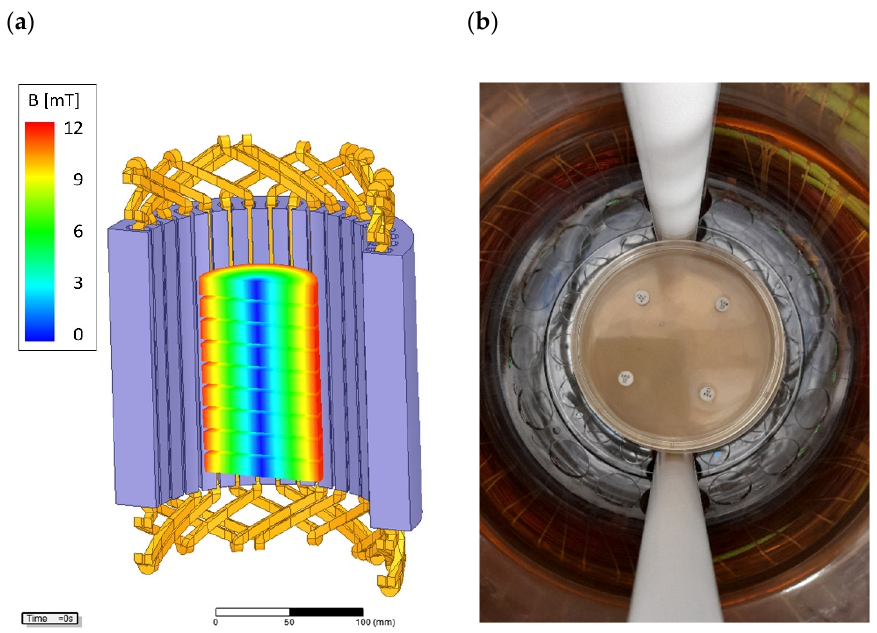
Figure 11. ( a ) Arrangement and location of the Petri dishes and ( b ) antibiotic discs in RMF reactor chamber.